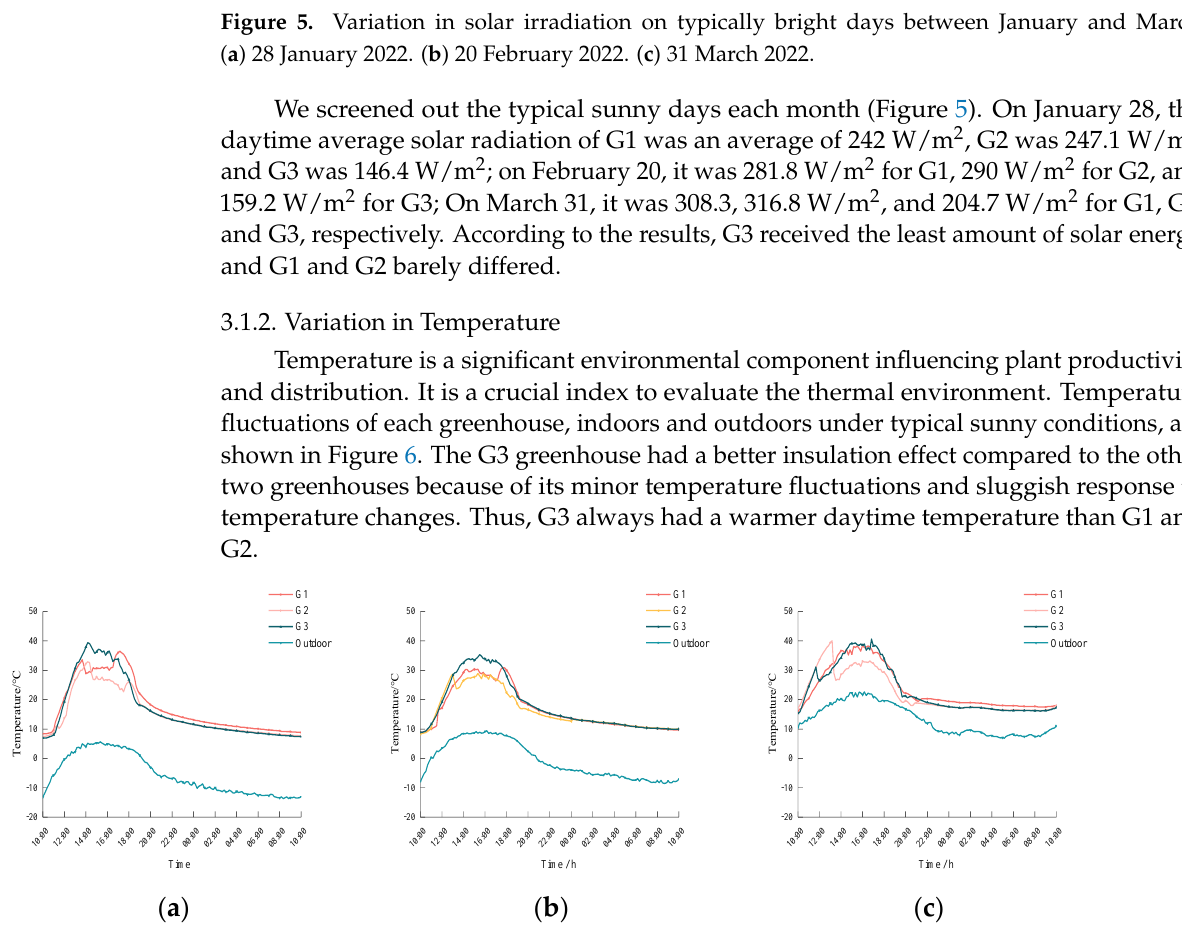
Figure 6. Temperature variation of CSGs on typical sunny days from January to March. ( a ) 28 January 2022. ( b ) 20 February 2022. ( c ) 31 March 2022.